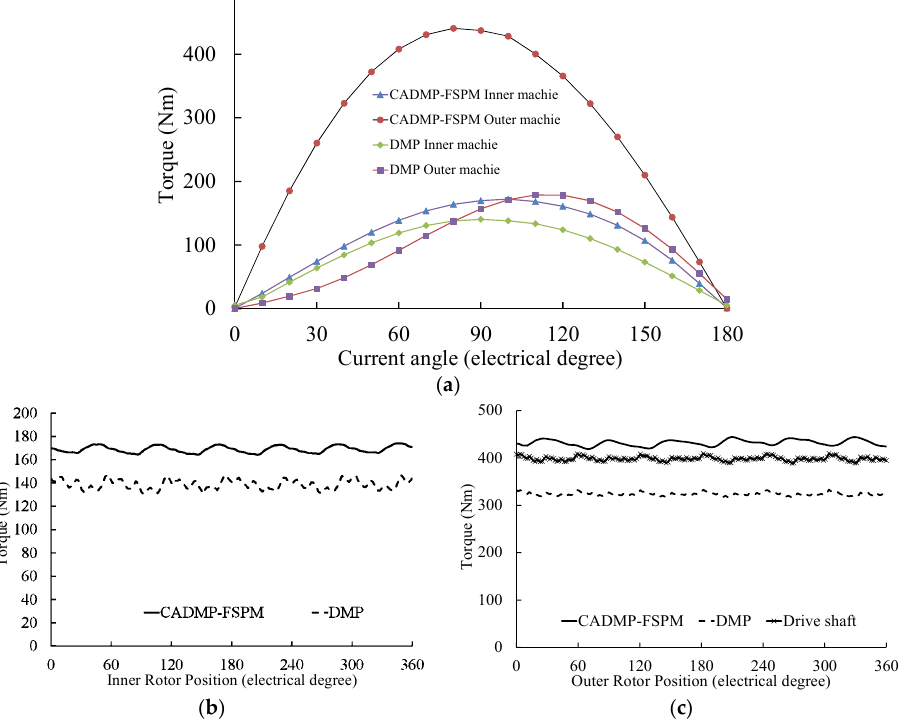
Figure 10. Electromagnetic torque waveforms of two machines. ( a ) Relationship between torque and current angles; ( b ) Inner machines; ( c ) Outer machines and the drive shaft of the DMP machine ‐ based E ‐ CVT system.